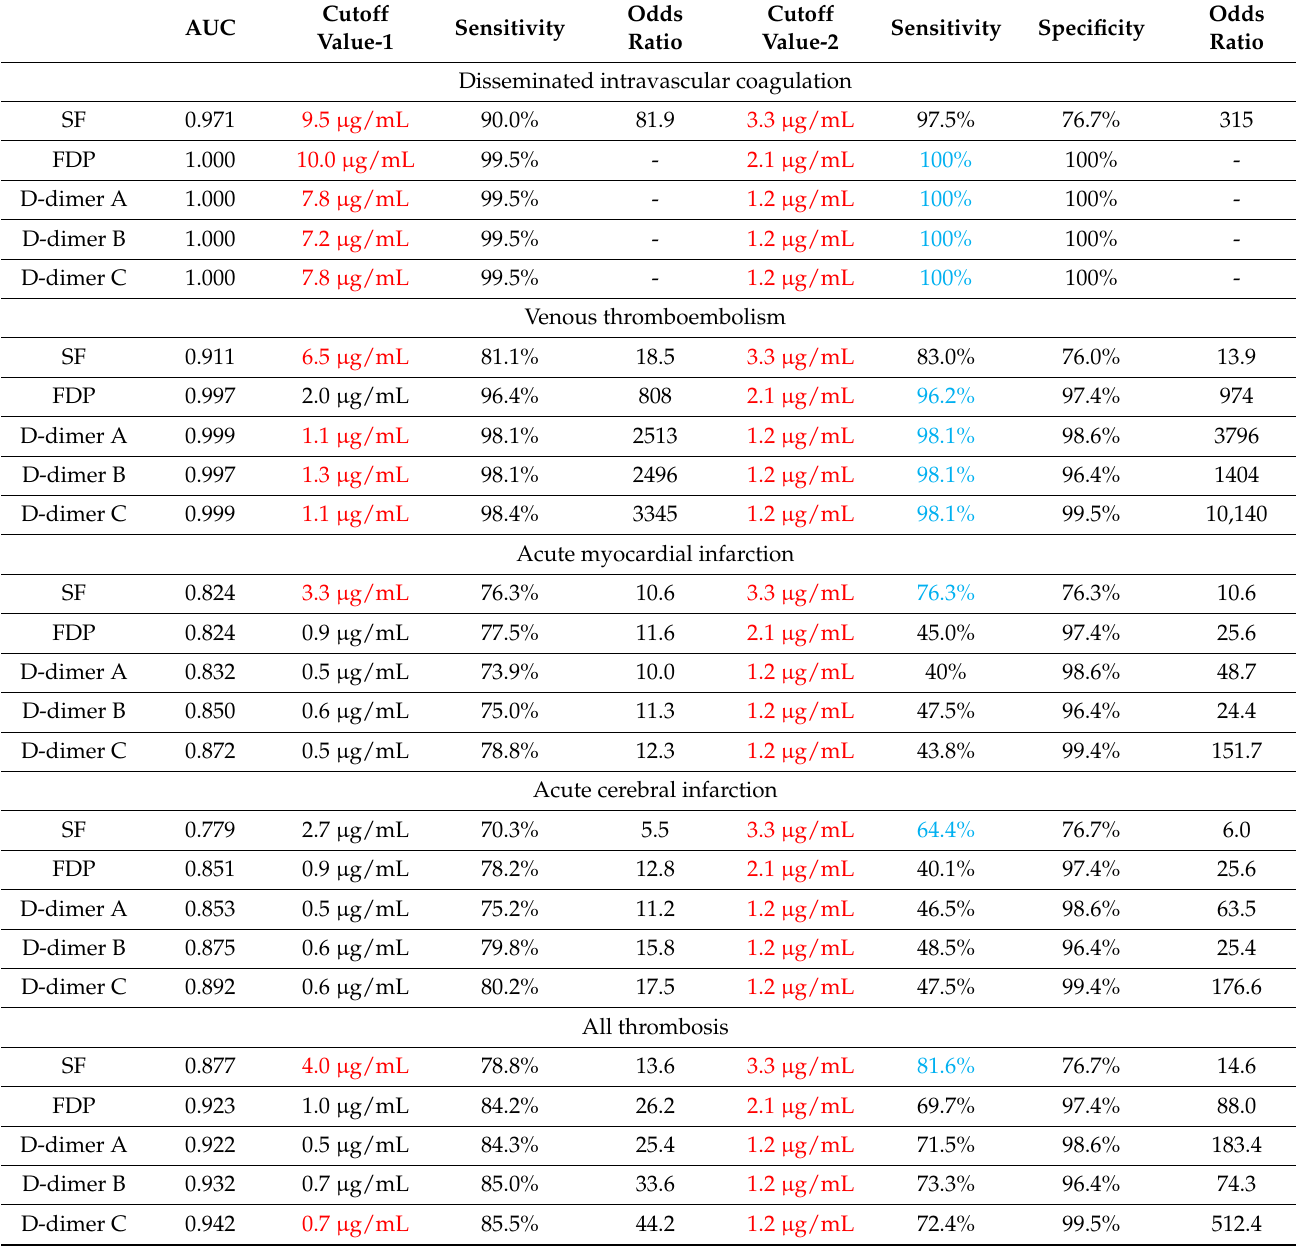
Table 4. ROC analysis of FDP, D-dimer, and SF for disseminated intravascular coagulation, venous thromboembolism, acute myocardial infarction, acute cerebral infarction, and all